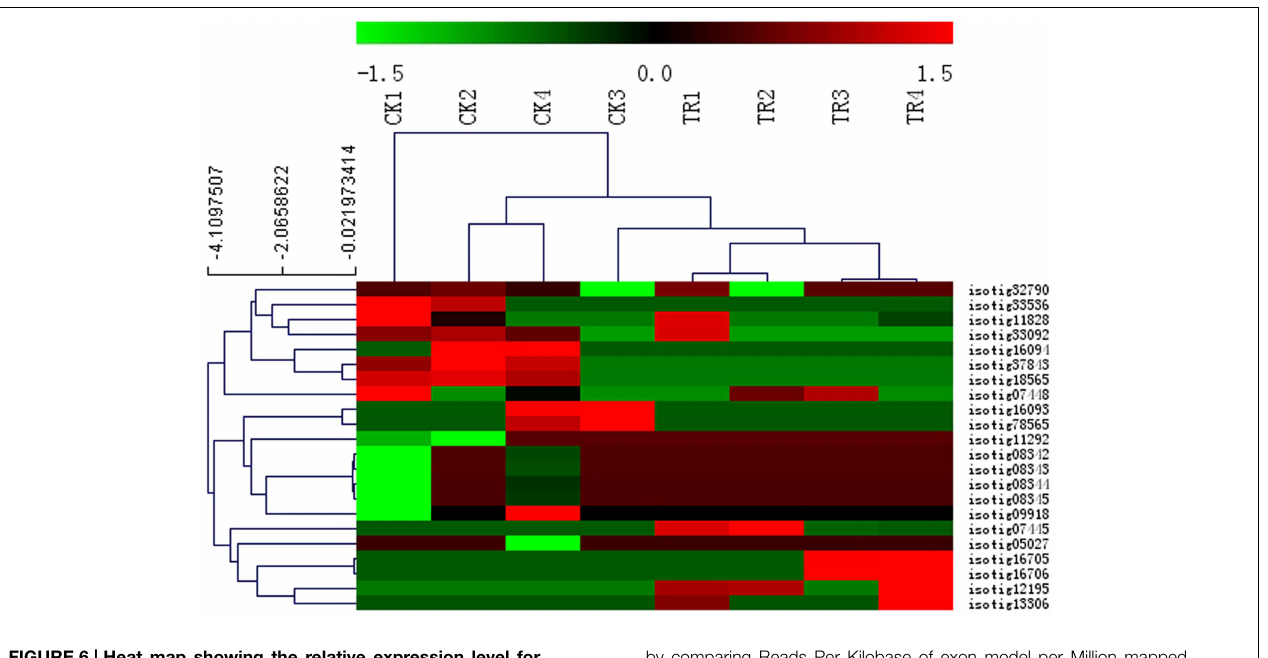
by comparing Reads Per Kilobase of exon model per Million mapped reads (RPKM). Hierarchical clustering of genes and samples was shown in the dendrogram on the top and side of the heatmap using the complete linkage